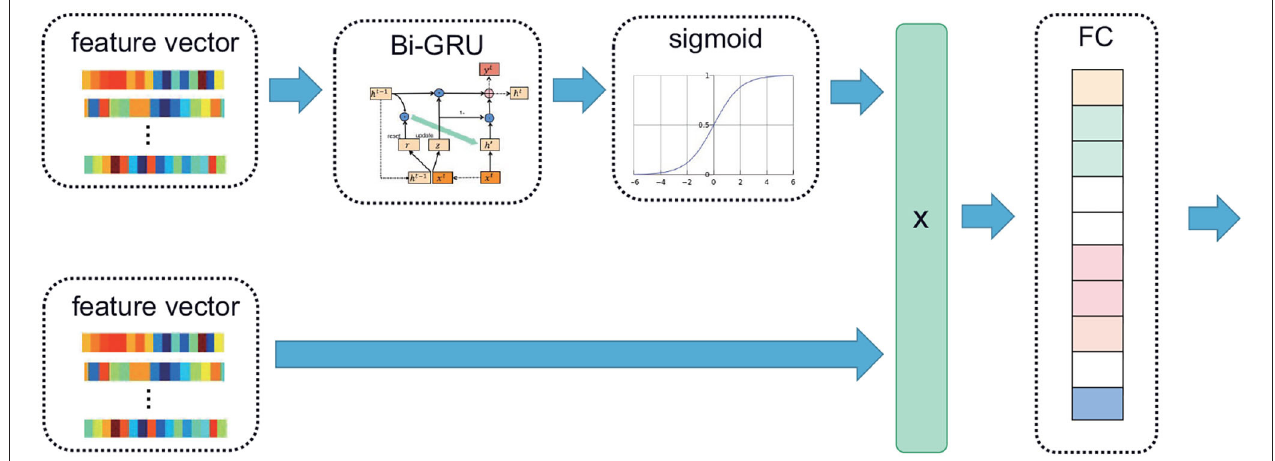
FIGURE 3 | The time attention mechanism. The feature vector extracted from the PSG is input into the Bi-GRU; the time continuity information of the signal is extracted, and high weight is assigned to the time series with high correlation using the sigmoid function. The attention matrix of the same dimension as the feature vector is multiplied with the original feature vector, and the multiplied vector is sent to the linear layer.